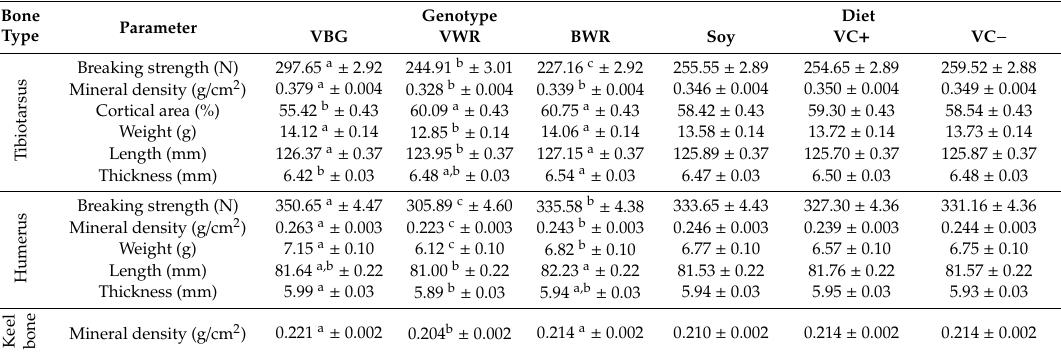
Table 7. LS-means ± SE for characteristics of tibiotarsus, humerus and keel bone under the e ff ect of genotype and diet for experiment B (crossbreds) ( n =